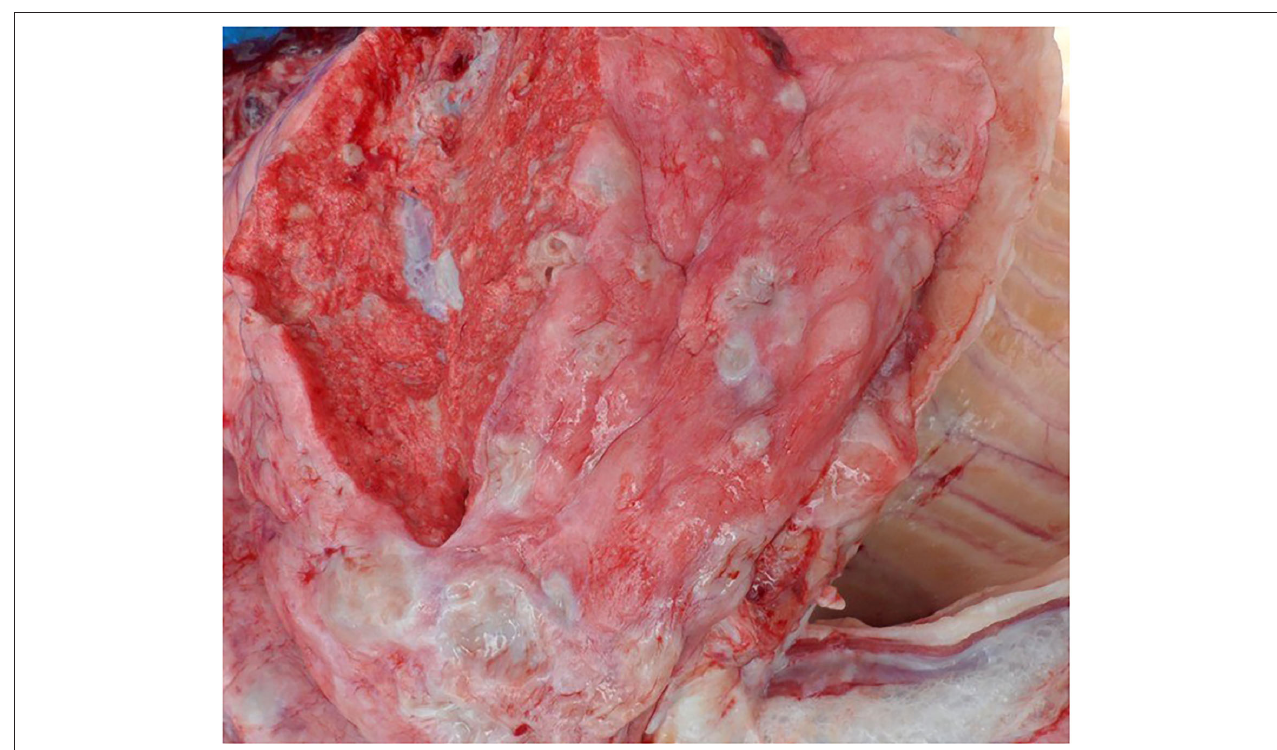
FIGURE 1 | Lungs showing nodular lesions distributed throughout the parenchyma with central caseous necrosis.